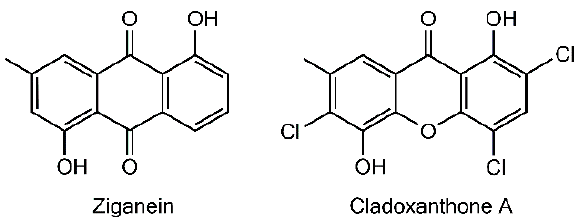
Figure 7. Compared chemical structures of ziganein and cladoxanthone A.